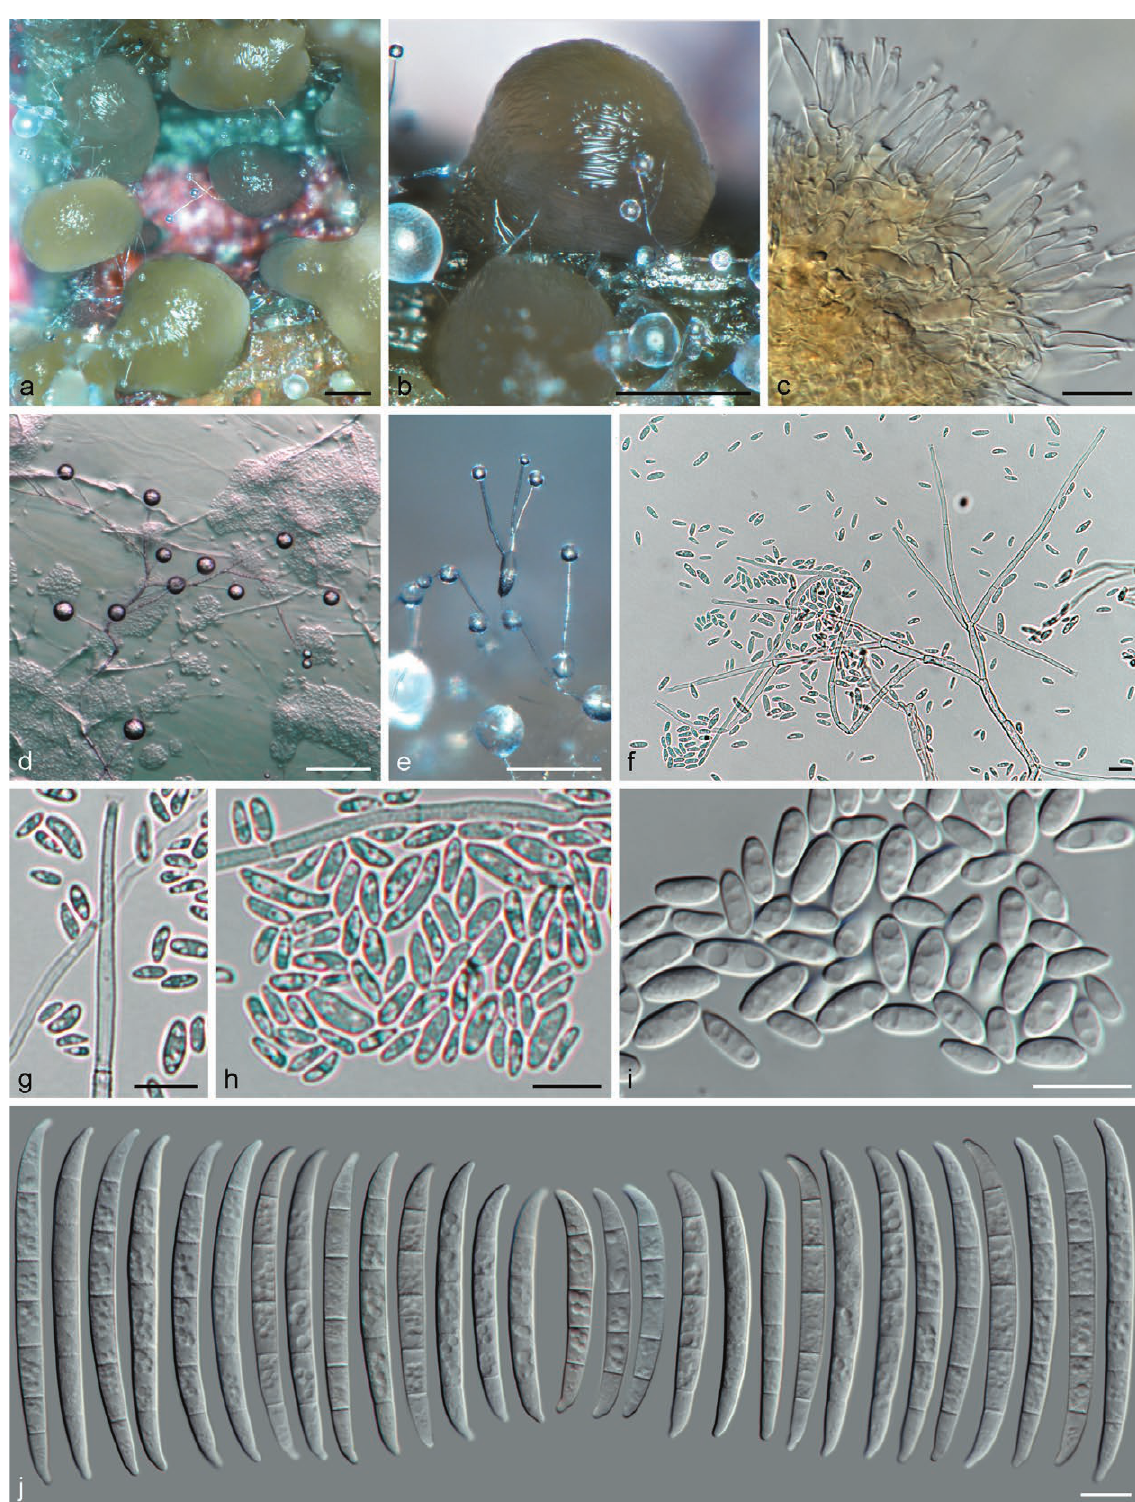
Figure 7. Neocosmospora lerouxii (ex-type culture CBS 146514). (a and b) sporodochia formed on the surface of carnation leaves; (c) sporo- dochial conidiophores and phialides; (d tog) aerial conidiophores and phialides; (h and i) aerial conidia; (j) sporodochial conidia. Scale bars: a and b = 100 μm; d and e = 50 μm; f to j = 10